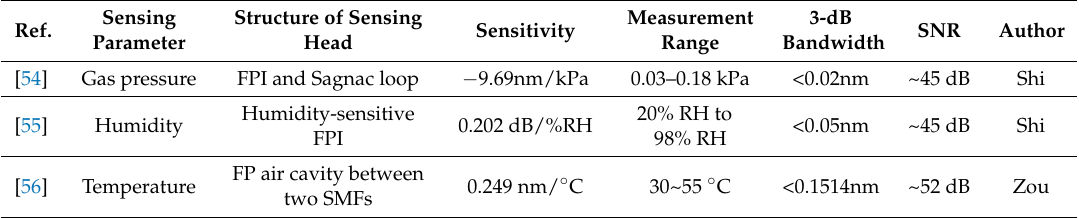
Table 2. Fabry–Perot Interferometer typed